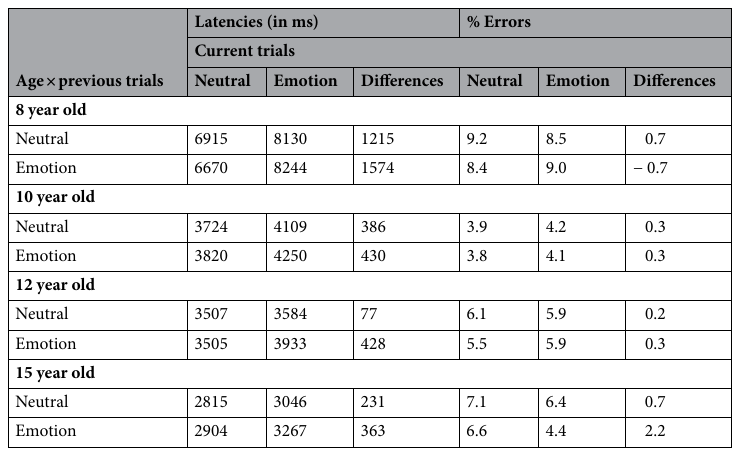
Table 2. Mean solution times (in ms) and percentages of errors for current neutral or emotion trials following neutral or emotion